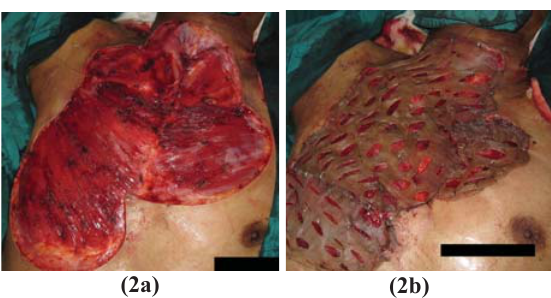
Figure 2. Exposed muscles of anterior chest after wide resection of tumor including deep fascia and muscle aponeurosis (2a), wound covered with split skin